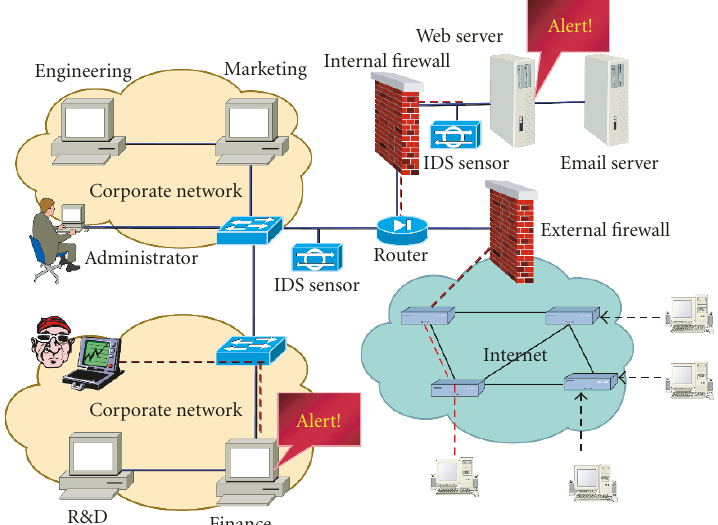
Figure 1: The intrusion detection system and external/internal network intrusion